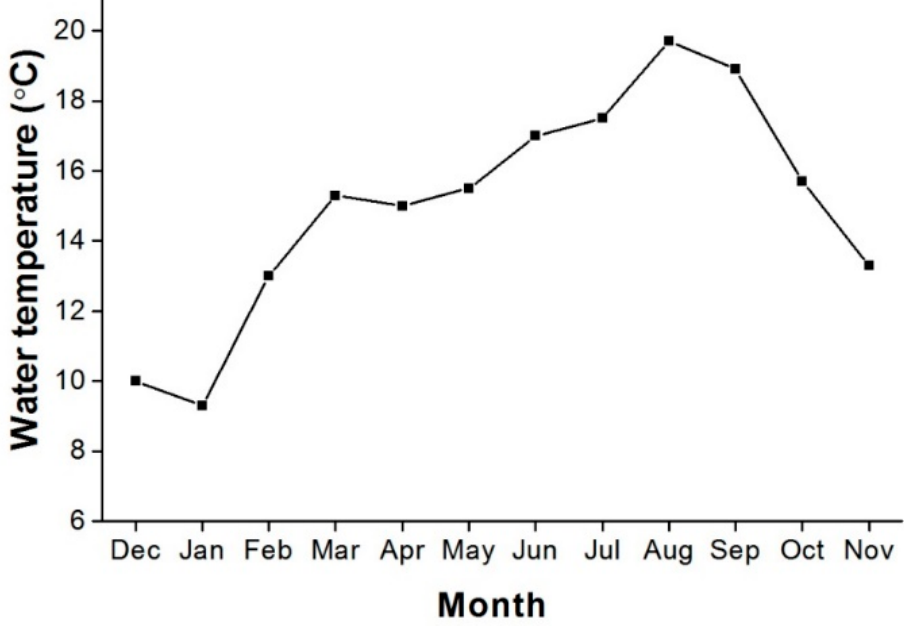
Figure 9. Monthly variation in water temperature at Motuo, the lower reaches of the Yarlung Zangbo River between December 2015 and November 2016.